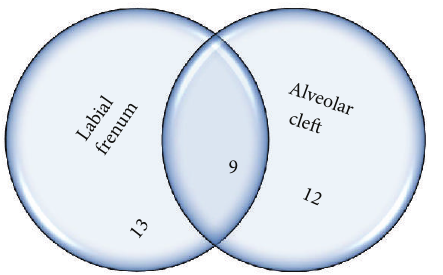
Figure 6: Intersecting circles chart depicting the common occur- rence between labial frenum and alveolar